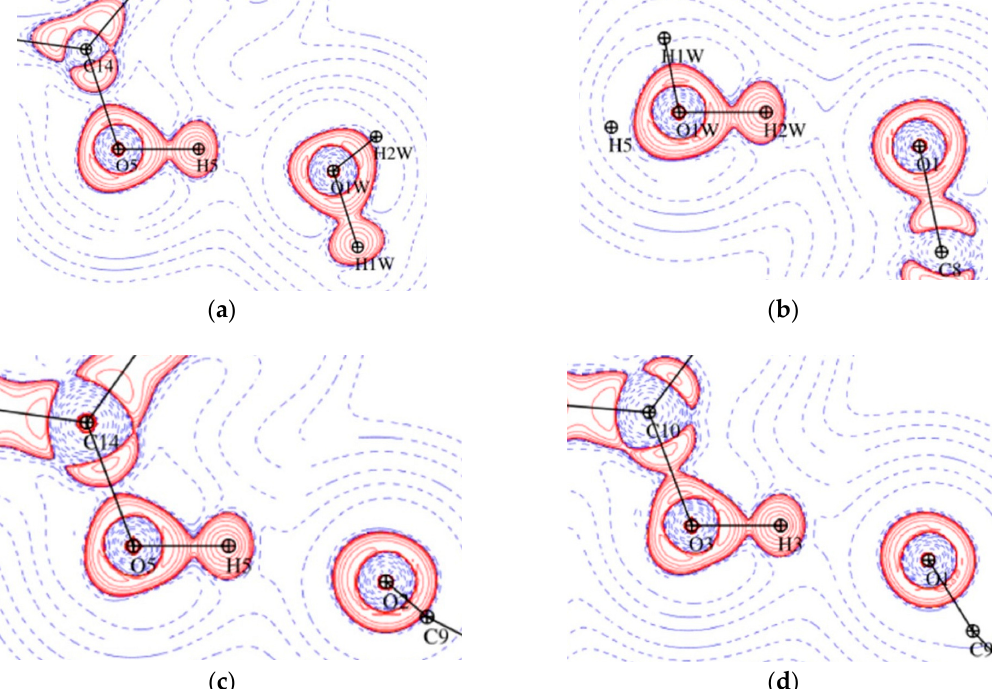
Figure 10. Representation of O-H···O hydrogen bonds in Laplacian maps for 1 O5-H5···O1W plane ( a ) , O1W-H2W···O1 plane ( b ) and for 2 O5-H5···O2 plane ( c ) , O3-H3···O1 plane ( d ) , logarithmic contours in e Å − 5 . Red and blue contours denote positive and negative values, respectively.